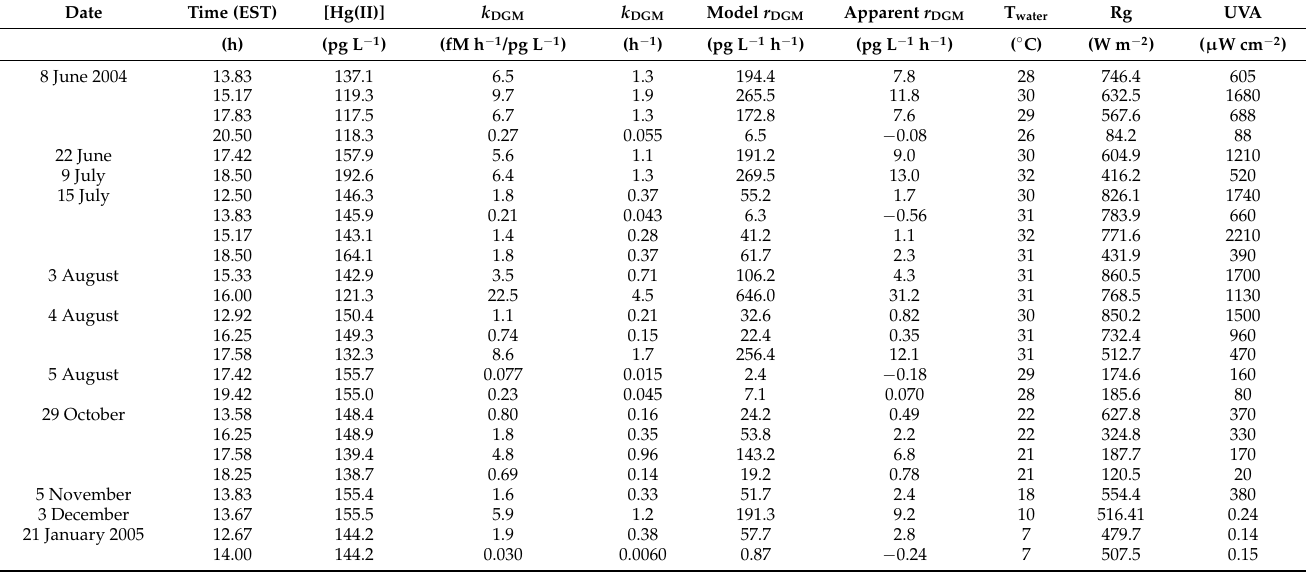
Table 1. Rate constants and rates of aquatic DGM photoproduction calculated by a simple mass balance box model and apparent rates of the DGM production calculated from DGM concentrations from field measurements.